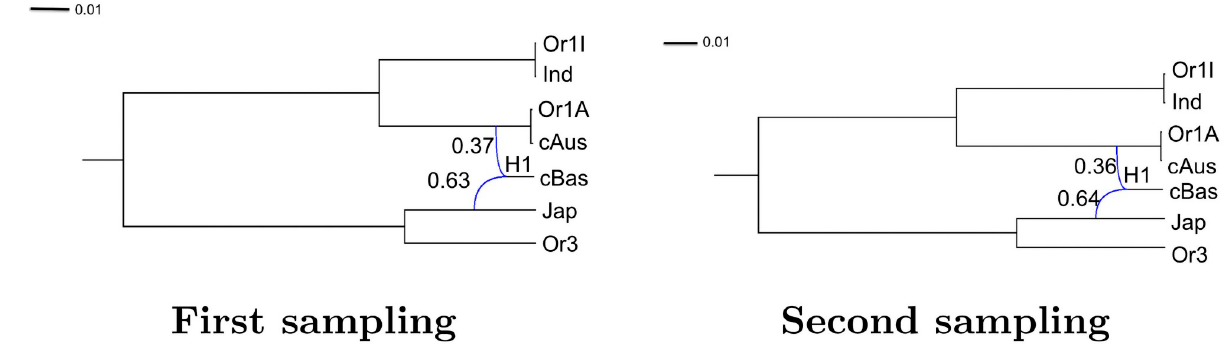
Fig 16. The two networks obtained for data set 2 with two varieties per subpopulation. Each network corresponds to the posterior mean of the distribution sampled by S NAPP N ET . Inheritance probabilities are reported above reticulation edges and branch lengths are given in units of expected number of mutations per site (see the scale at the top left).